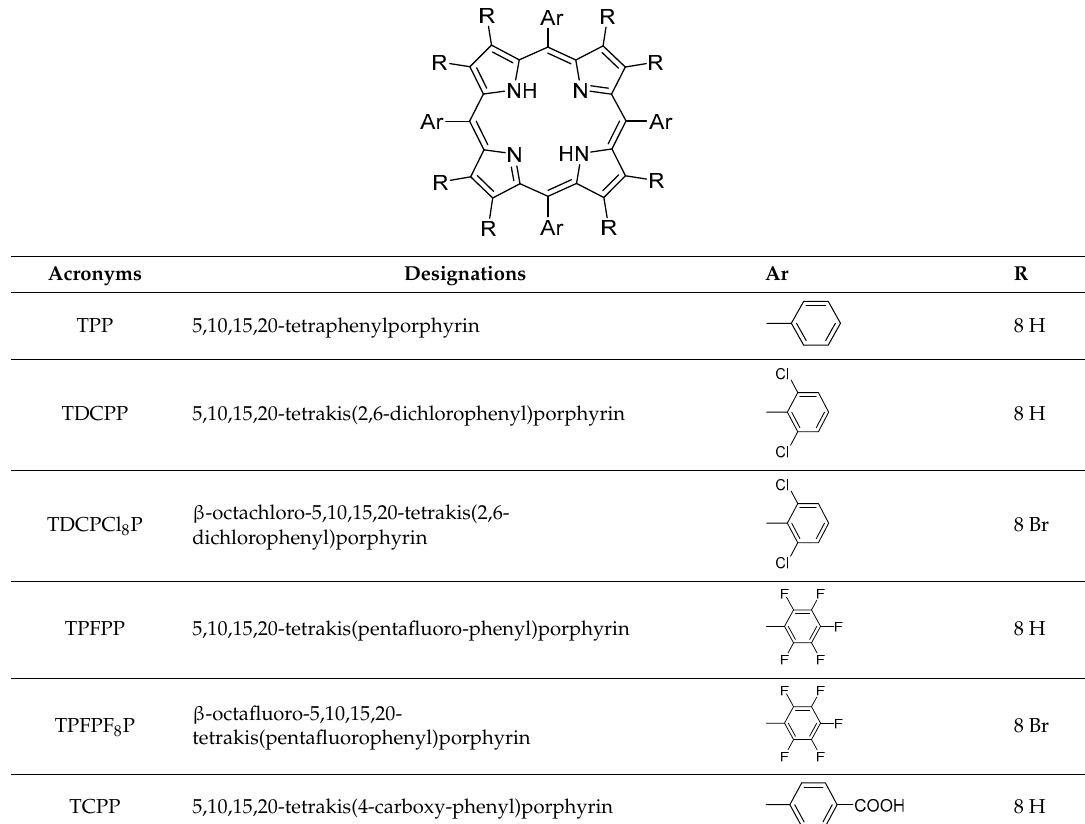
Table 2. meso -Tetrasubstituted porphyrins with and without substituents in the β -positions.